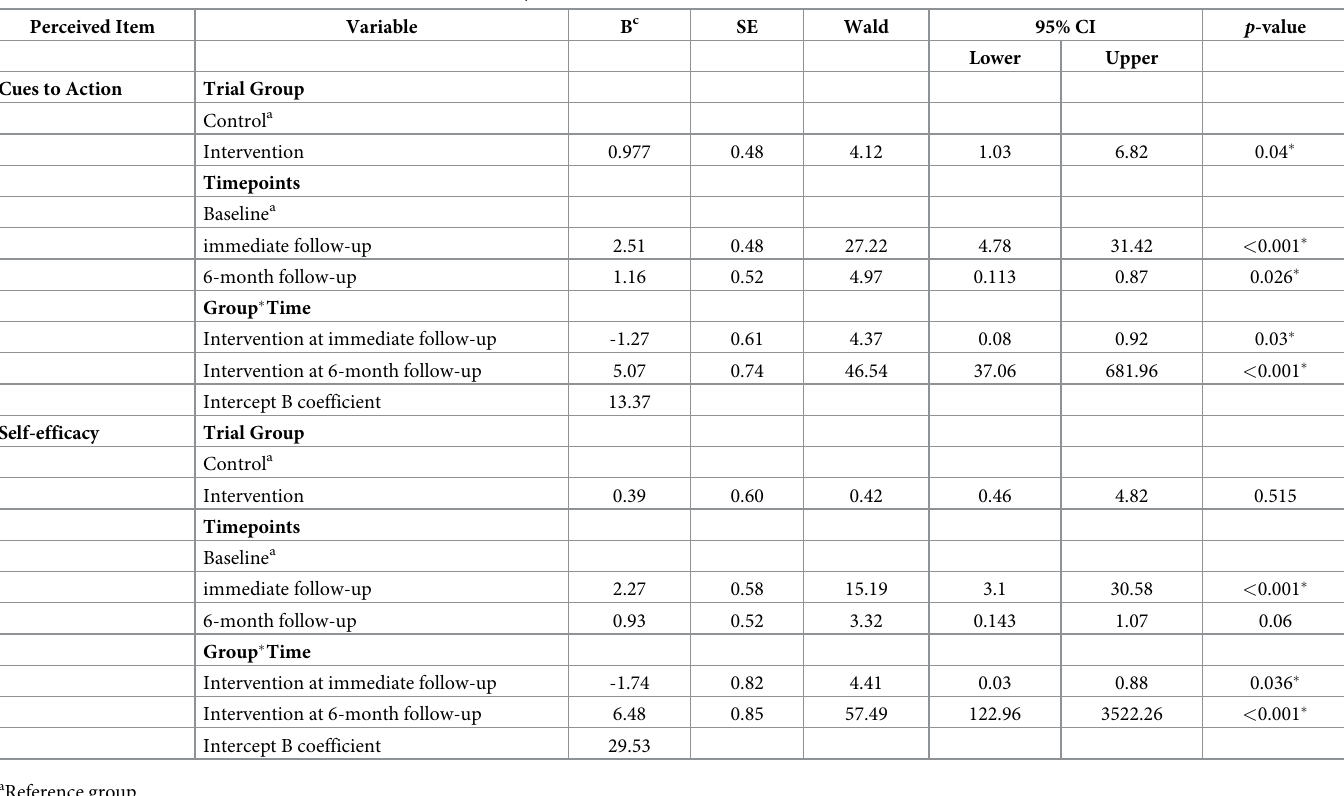
Table 9. Effectiveness of HEBI on cues to action and self-efficacy score.